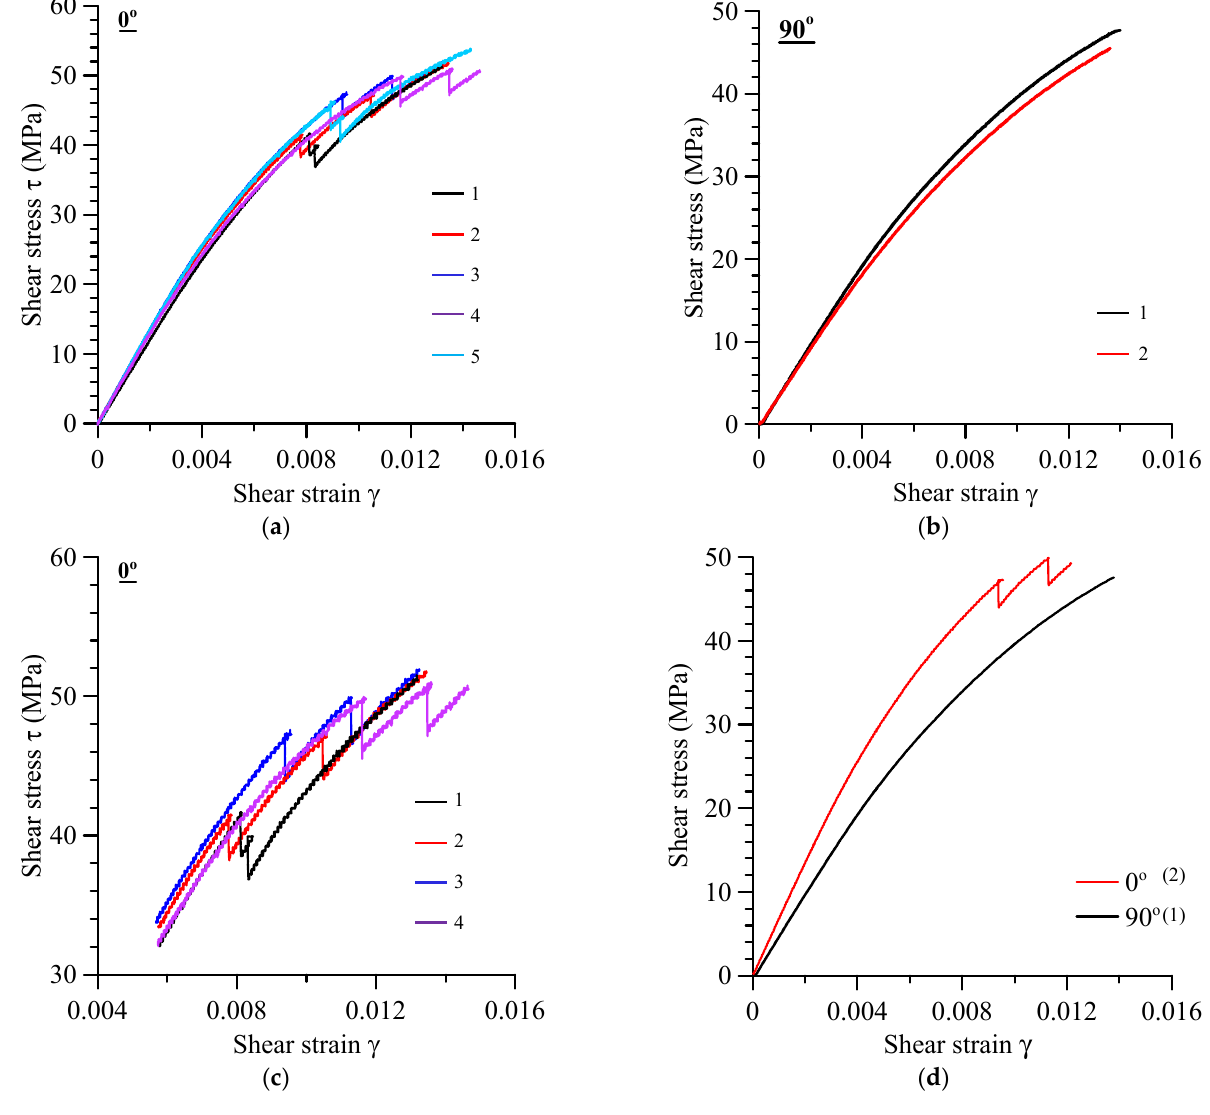
( a ) ( d ) Figure 10. Microscopic fracture modes developed during shear at different orientations; ( a , b ) 0°; ( c , d ) 90°. 3.2. Mechanical and Fracture Behavior in the Presence of Holes and Notches The following three paragraphs describe the experimental activity in tension, com- pression and shear loading using holed coupons, respectively. The results are given in terms of stress–strain curves. In addition, tabulated results are presented and the mac-